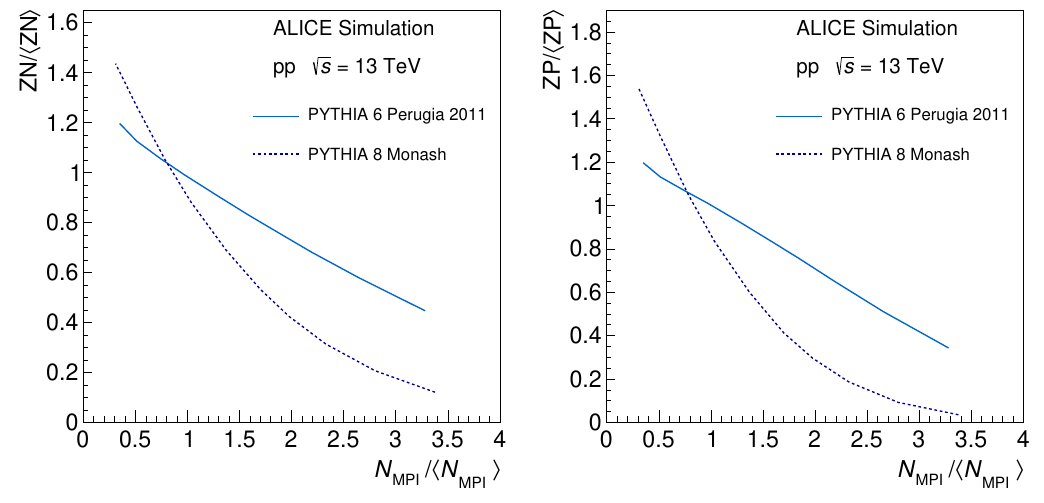
Figure 7 . Self-normalised ZN (left) and ZP (right) signal as a function of the number of self- normalised MPI extracted from PYTHIA 6 Perugia 2011 (solid line) and PYTHIA 8 Monash (dashed line)